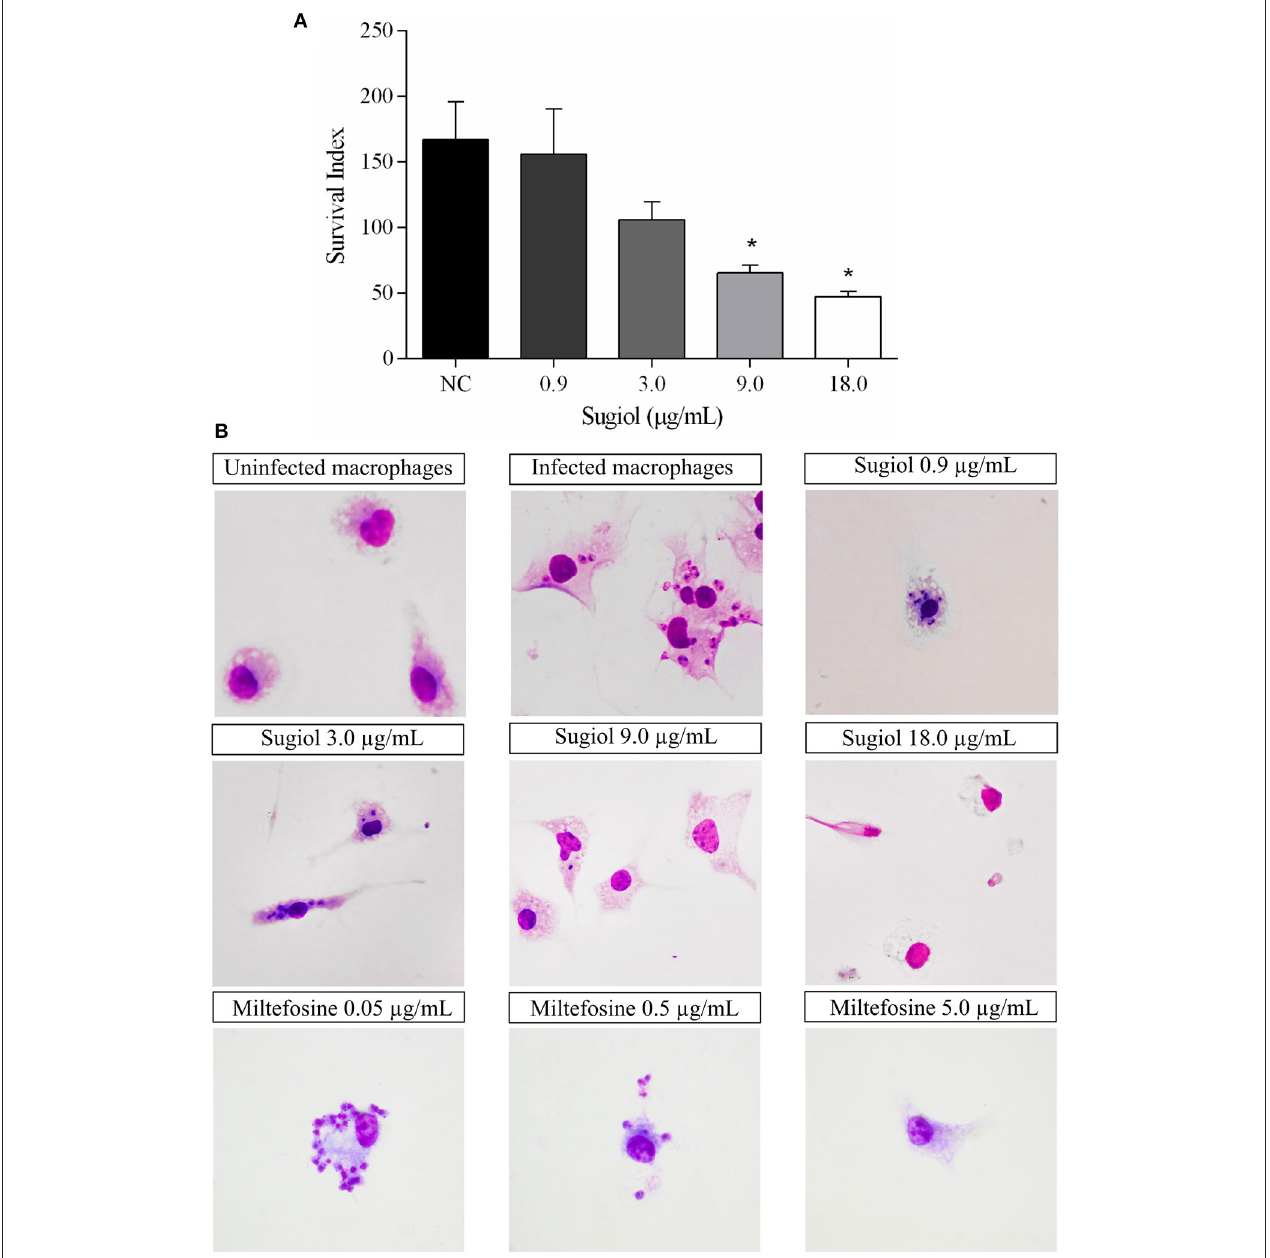
FIGURE 8 | Sugiol activity against L. infantum amastigote. Amastigote survival index within (A) untreated infected macrophages (NC) and after treatment with different concentrations of sugiol for 48h. Three independent experiments were performed and the results were expressed as the mean ± SD. * p < 0.05, significant difference compared to negative control (NC) group. Letter (B) shows the optical microscopy of untreated and treated infected macrophages. Miltefosine was used as a positive control. Magnification: 1000x.